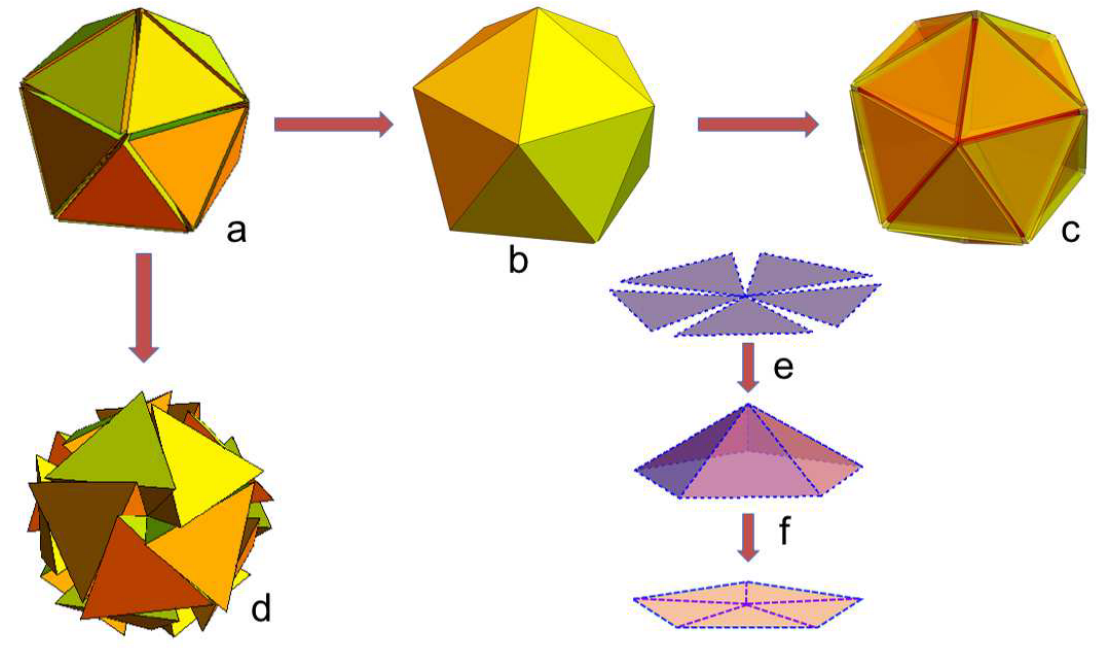
Figure 2. Symmetric arrangements of a 20-tetrahedron vertex sharing cluster: ( a ) with open gaps; and then with gaps closed by: ( b ) discrete curvature; ( c ) distortion; and ( d ) twisting. ( e , f ) The 2D analogue of the transition from gaps to discrete curvature and then to